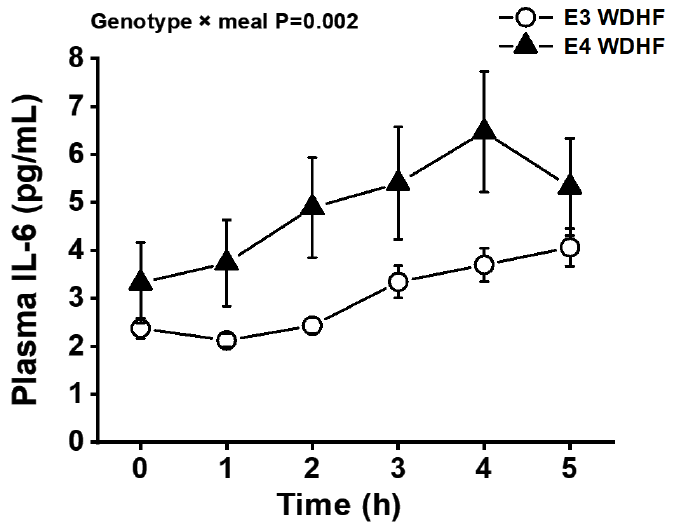
Figure 2. Effect of the APOE genotype (E3 vs. E4) on the plasma IL-6 response to a Western-like diet high-fat (WDHF) meal in high CVD risk individuals. Data are represented as the mean ± SEM. p = 0.002 for genotype × test meal interaction; * p < 0.05 for post-hoc differences between E3 and E4; p < 0.001 for the fixed factor time.